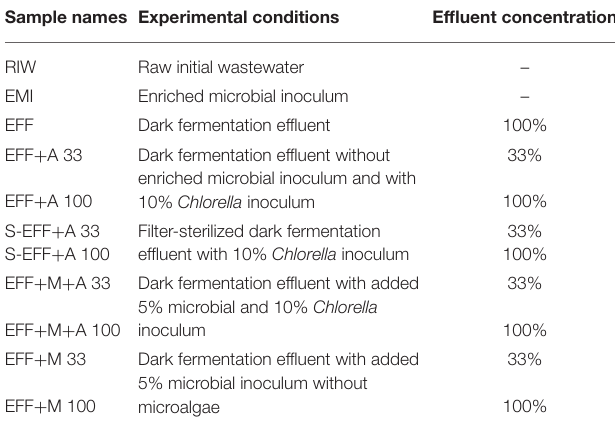
TABLE 1 | Experimental conditions and sample specifications in the photoheterotrophic degradation